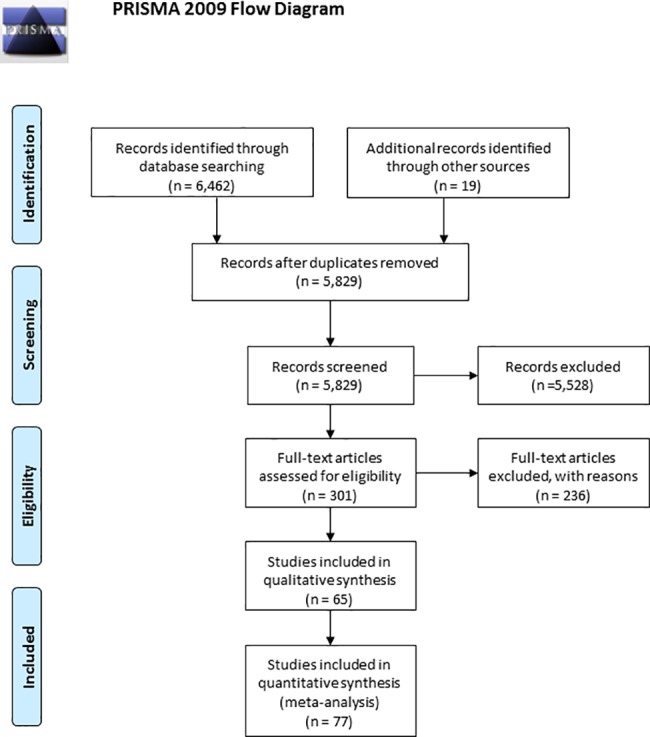
PRISMA flow diagram.